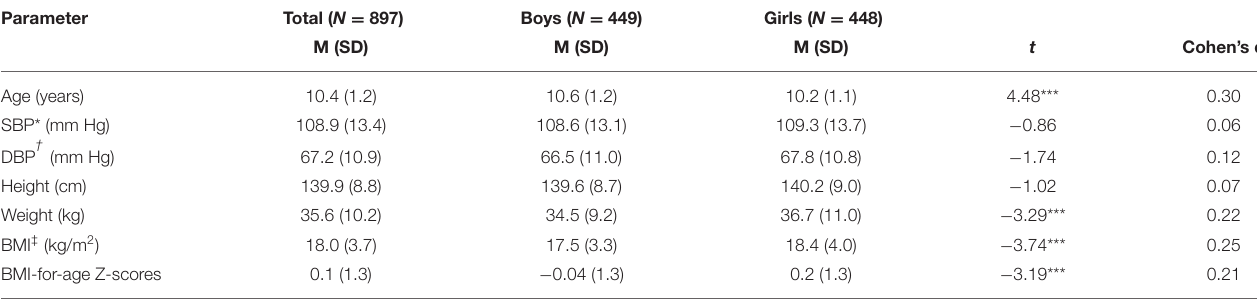
TABLE 1 | Participant characteristics and comparison between South African girls and boys from the KaziBantu study population in Gqeberha, South Africa. Parameter